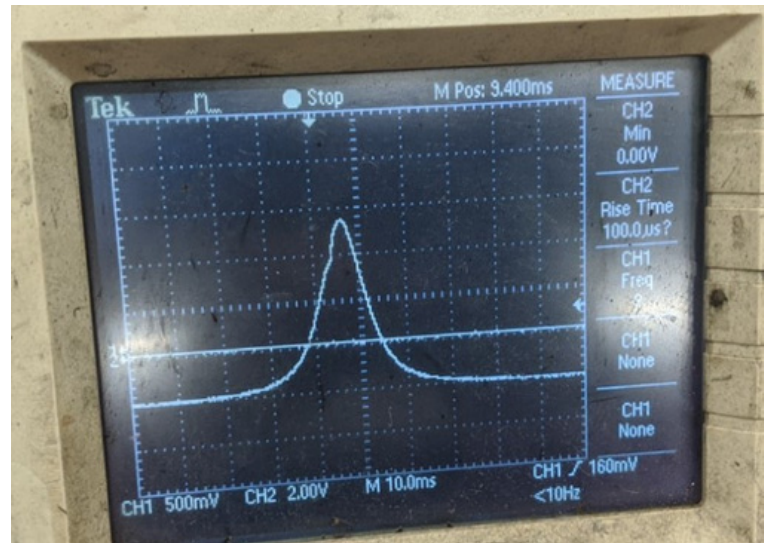
Figure A5. BSL retarded injection timing at operating temperature, or Case 3 of Table 1. The fact that these conditions are of a retarded injection timing can be concluded by the fact that the premixed combustion started at a pressure about identical to PMP, indicating that combustion started around the TDC and most of the heat release took place after TDC. For some reason, the premixed combustion is not as well defined in this case, possibly due to the reduced compression ratio. The reading here is 38 bar gage, 39 bar absolute.